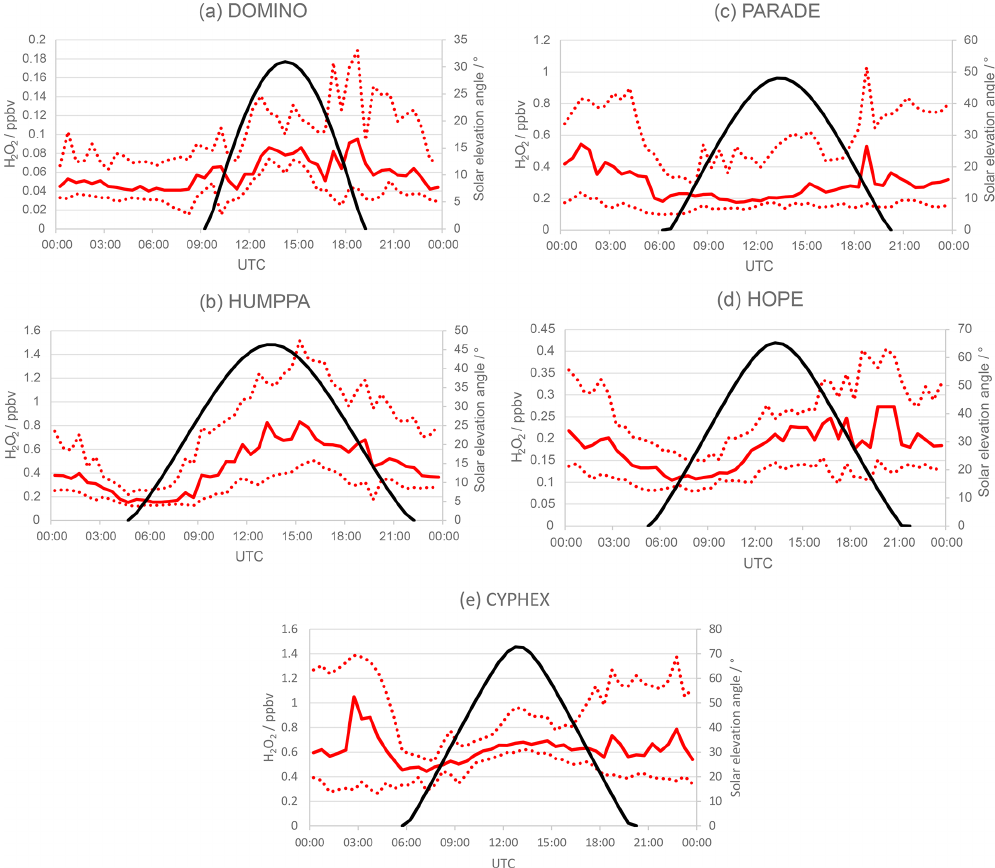
Figure 2. Hydrogen peroxide diel variation of median mixing ratios (solid read line) and 25% and 75% quartiles (dashed red lines) for 30min bins obtained for (a) DOMINO, (b) HUMPPA, (c) PARADE, (d) HOPE and (e) CYPHEX. Solar elevation angle is shown in black.